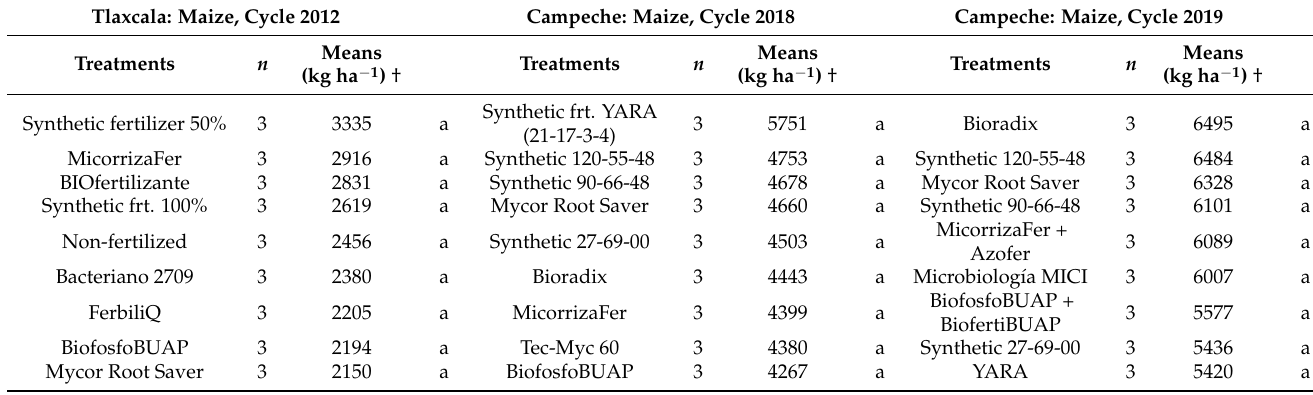
Table 10. Means of non-grouped experiments in Tlaxcala in 2012 and in Campeche in 2018 and 2019, to test the effectiveness of partially substituting synthetic fertilizers by biofertilizers in